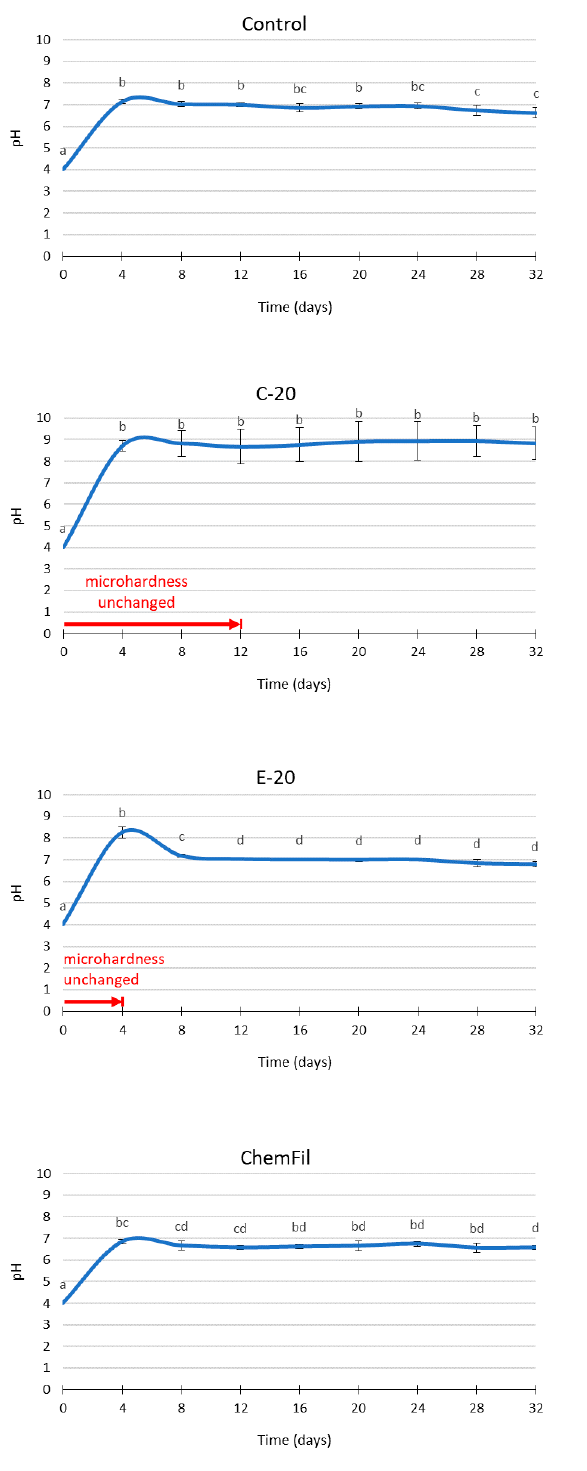
Figure 3. pH changes (mean values ± standard deviations) of the immersion medium and time periods for which dentin microhardness remained unchanged compared to initial values. Same letters denote statistically similar pH values within a material.